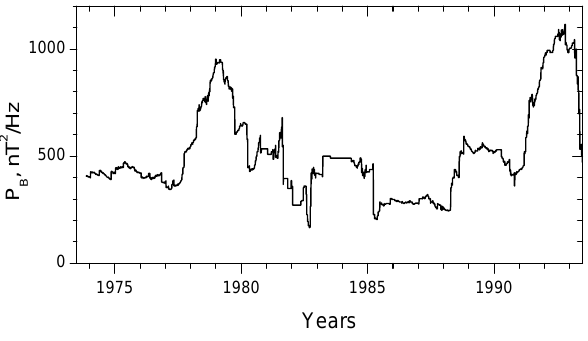
Fig. 4. The 2-year averaged power level of rapid fluctuations of the IMF